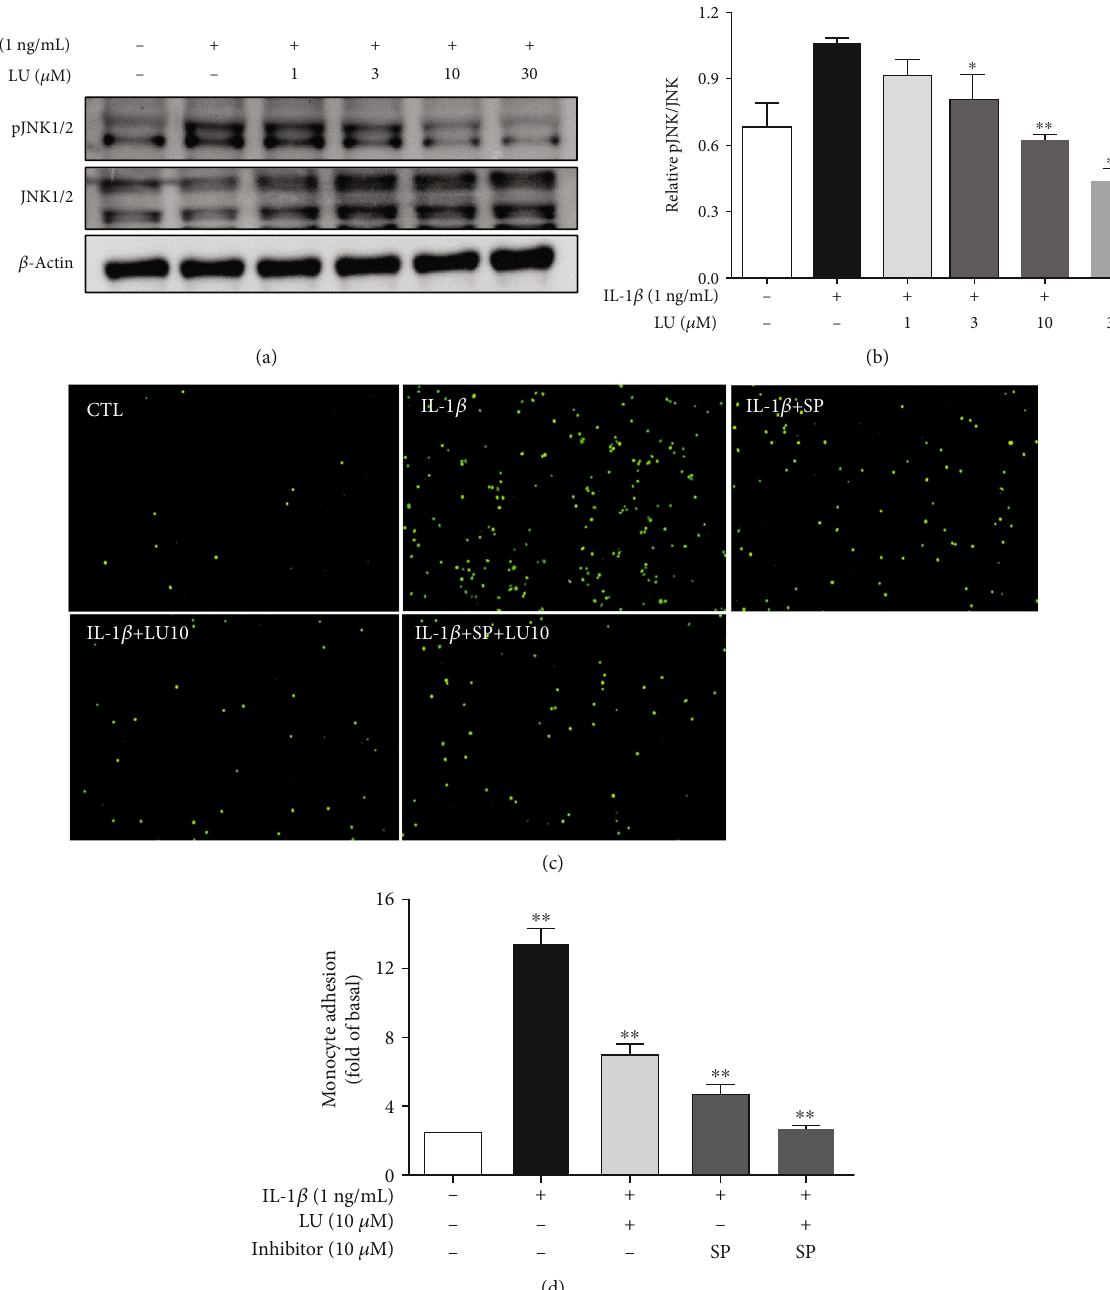
Figure 5: Luteolin blocked JNK phosphorylation, and the JNK inhibitor SP60012 (SP) decreased THP-1 cell adherence to IL-1 β -stimulated ARPE-19 cells. (a) Western blots show the levels of phosphorylated JNK protein expression. (b) The fold-change in pJNK protein expression was measured relative to JNK expression. (c) ARPE-19 cells were pretreated with 10 μ M luteolin or JNK inhibitor (SP600125) for 1h and then cocultured with labeled THP-1 cells. (d) The fl uorescence intensity was used to quantify calcein-AM fl uorescence. Data represent the mean ± SD . ∗ p < 0 : 05 , ∗∗ p < 0 : 01 , compared to ARPE-19 cells stimulated with IL-1 β